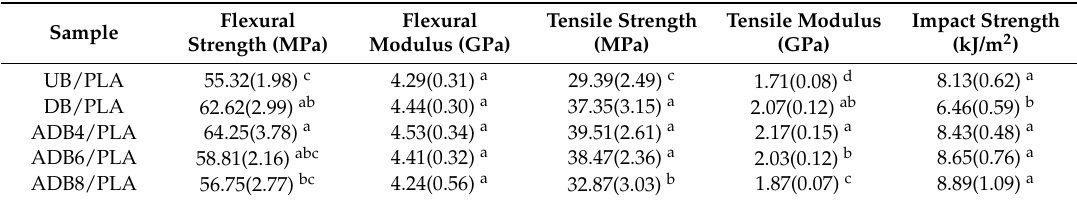
Table 2. Mechanical properties of the fiber-reinforced UB/PLA, DB/PLA, ADB4/PLA, ADB6/PLA, and ADB8/PLA composites.